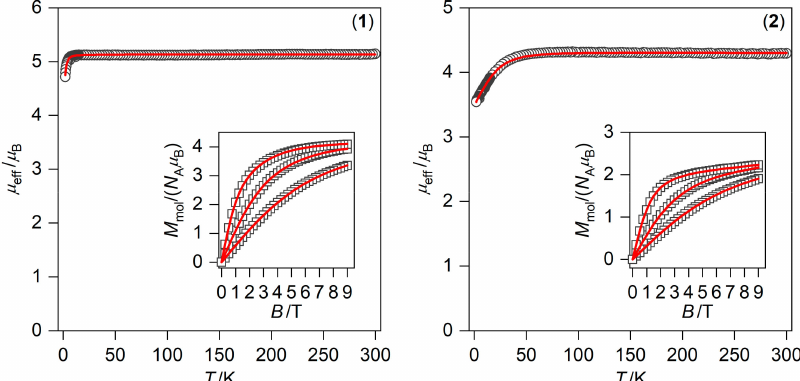
Figure 3. Magnetic data for 1 and 2 shown as the temperature dependence of the e ff ective magnetic moment and as the isothermal magnetizations measured at T = 2, 5, and 10 K. The empty circles represent the experimental data. Red full lines represent the fitted data using Equation (1) with D = − 1.23 cm − 1 , E / D = 0.31, g iso = 2.09 for 1 and D = − 21.2 cm − 1 , E / D = 0.32, g xy = 2.13, g z = 2.37 for